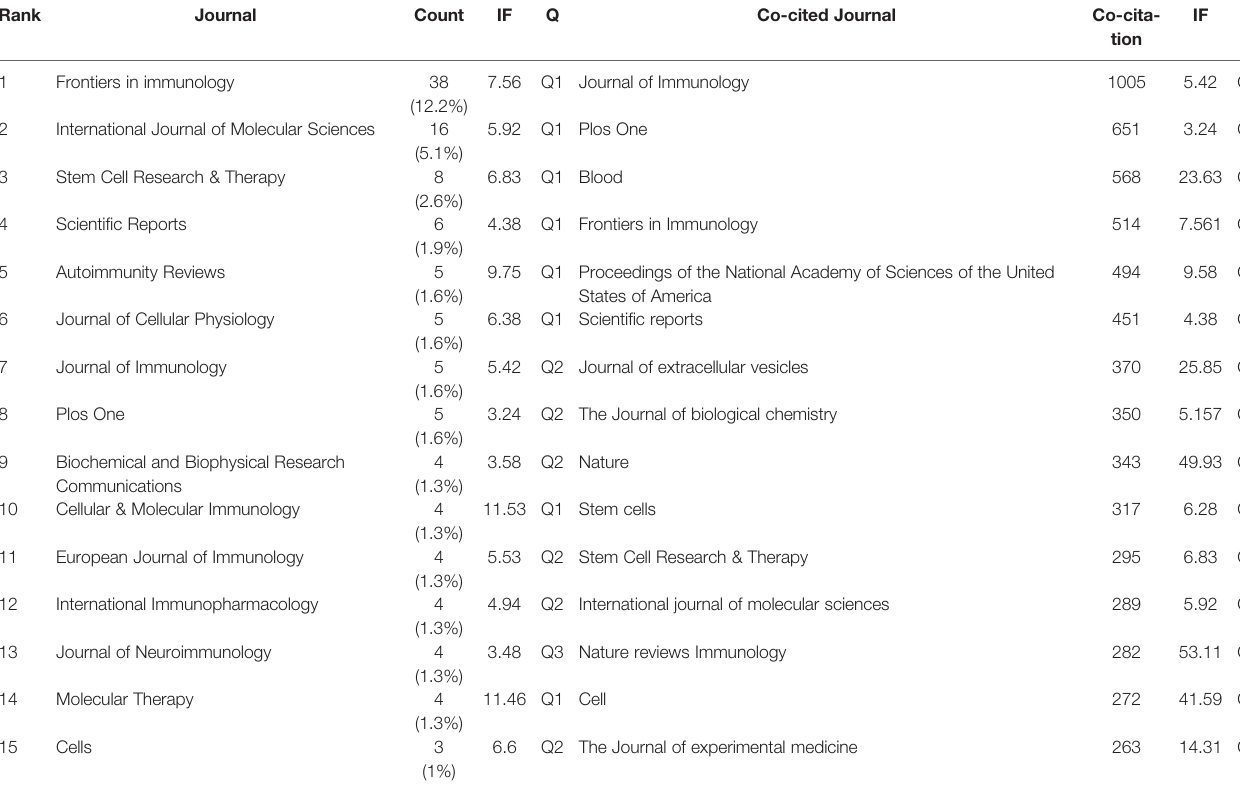
TABLE 2 | Top 15 journals and co-cited journals for research of exosomes in AIDs.